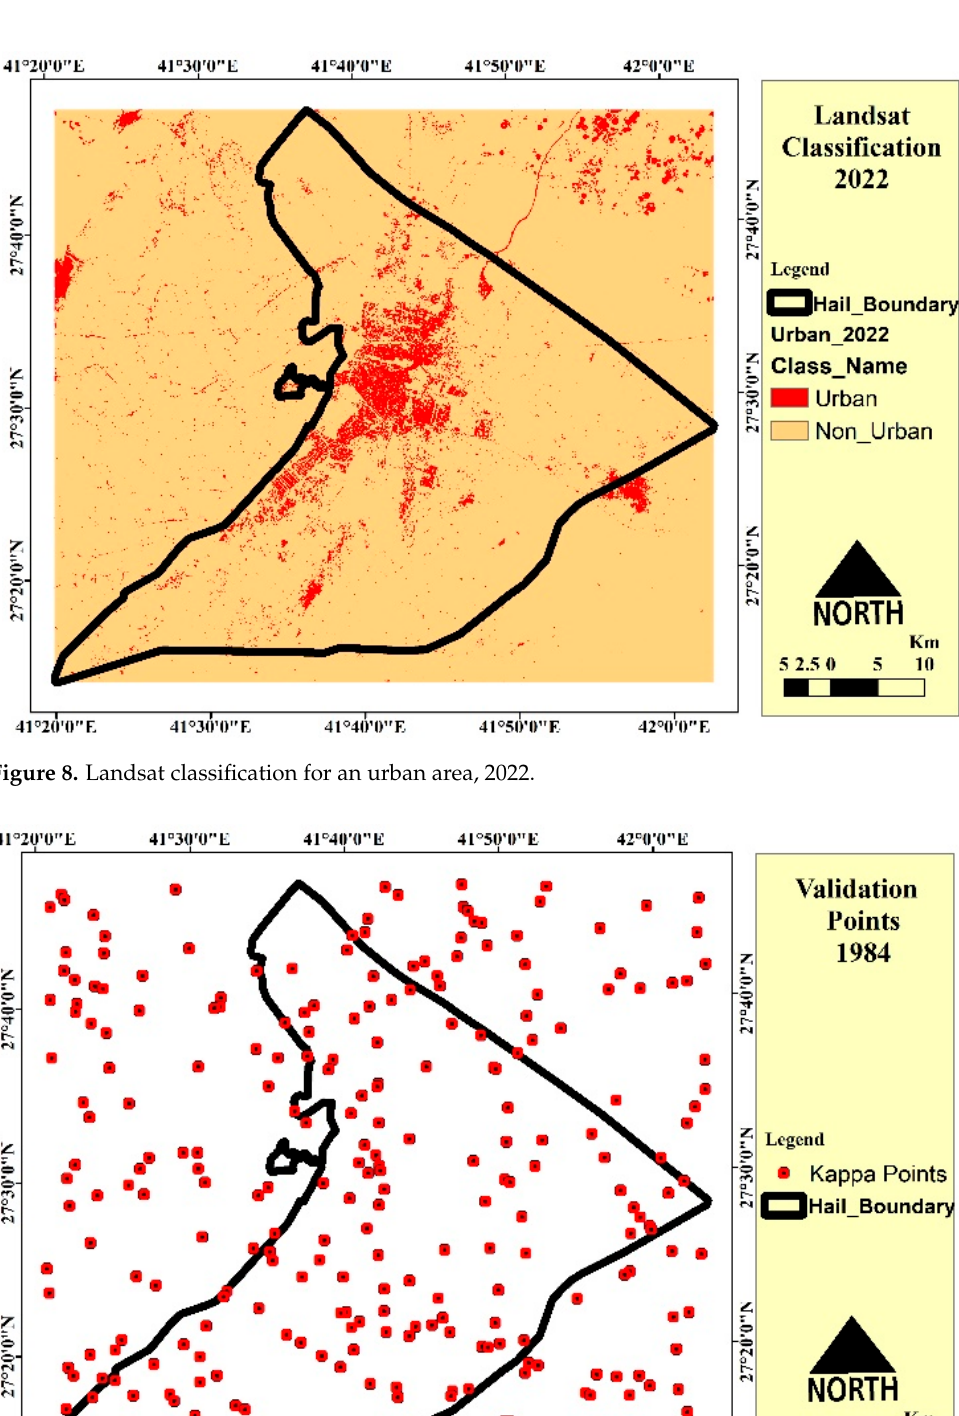
Figure 10. Distribution of Kappa validation points for 2022. Table 3. Kappa results for land use classification, 1984. Class Value